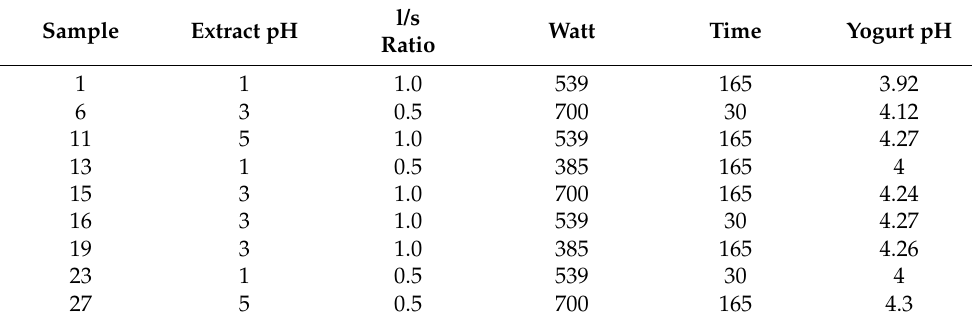
Table 4. Extracts incorporated in strained